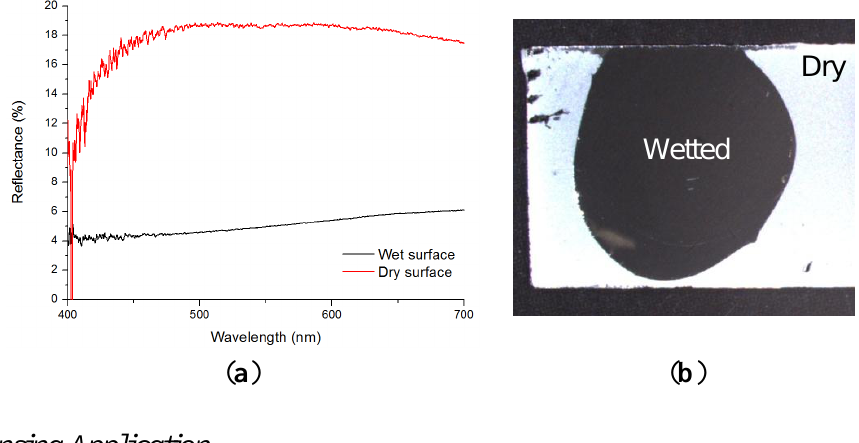
Figure 7. ( a ) Reflectance spectrum of the Pieris rapae butterfly replica in the case of a dry and wetted surface with DI water; ( b ) picture of the surface with a dry and a wet circular area qualitatively showing the same effect of light scattering decrease due to the wet